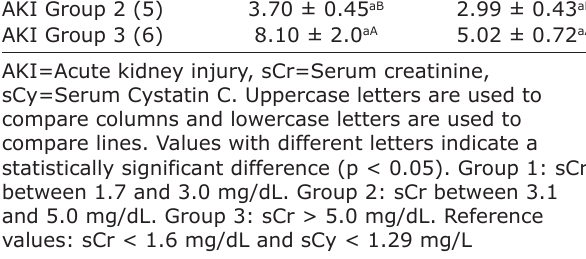
sCr sCr=Serum creatinine, sCy=Serum cystatin C Table-4: Means and standard deviations of sCr and sCy of healthy dogs with AKI. Group (n) sCr (mg/dL) sCy (mg/L) Control (19)